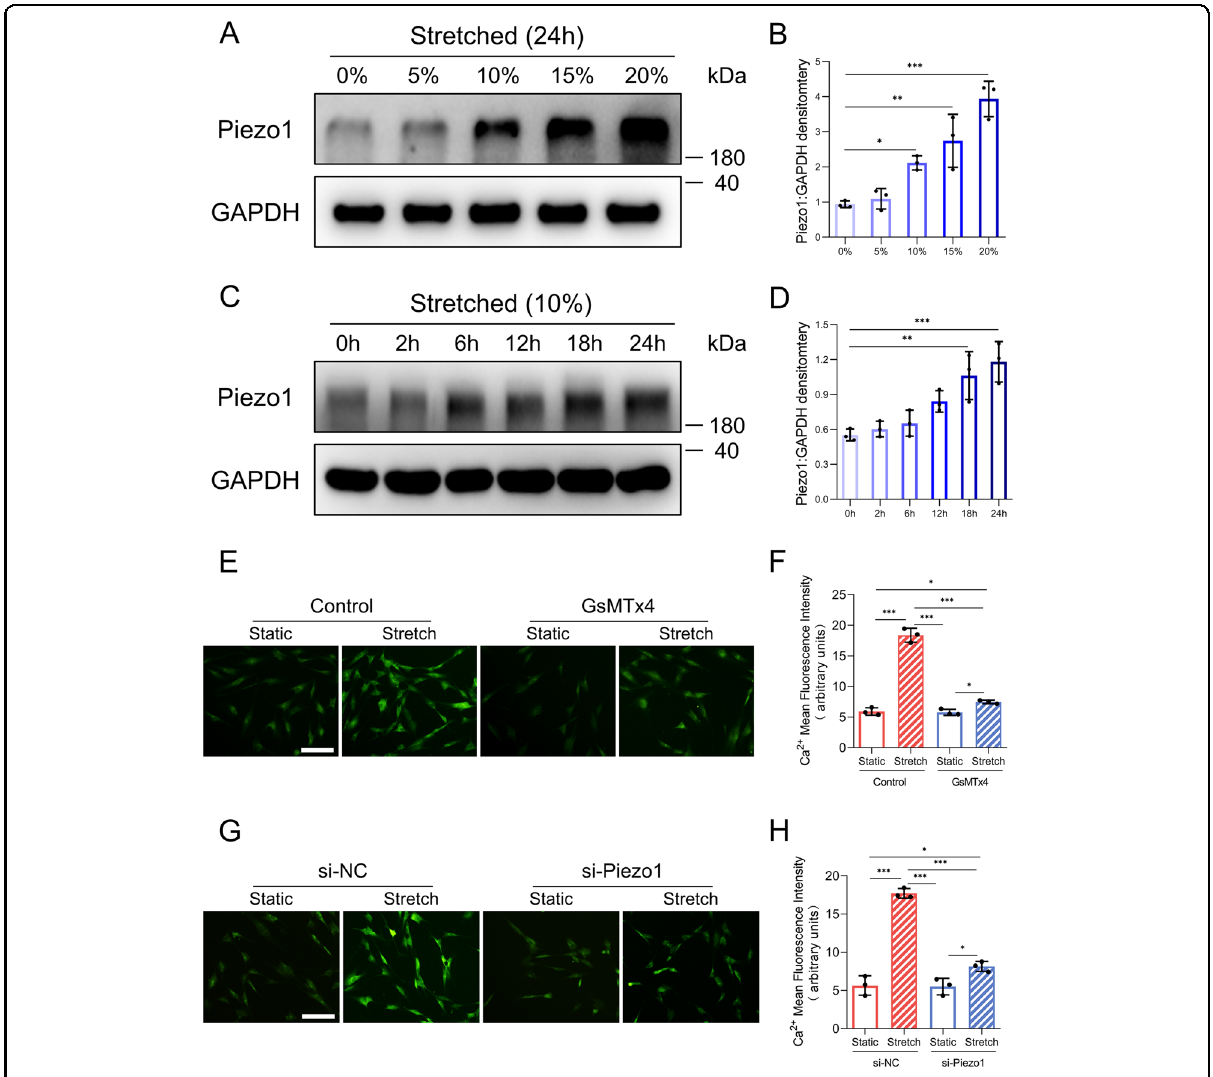
Fig. 2 Piezo1 expression and Piezo1-dependent calcium in fl ux in HDFs subjected to CMS. A Expression of Piezo1 in HDFs was determined by western blotting in a strength dependent manner. B Quantitative analysis of the expression level of Piezo1. C Expression of Piezo1 in HDFs was determined by western blotting in a time-dependent manner. D Quantitative analysis of the expression level of Piezo1. E Representative fl uorescence images of intracellular Ca 2 + in HDFs. (Scale bar: 100 μ m). F Mean fl uorescence intensity quanti fi cation of Ca 2 + levels in HDFs. G Representative fl uorescence images of intracellular Ca 2 + in HDFs in the context of Piezo1 knockdown. (Scale bar: 100 μ m). H Mean fl uorescence intensity quanti fi cation of Ca 2 + levels in HDFs in the context of Piezo1 knockdown. Ca 2 + concentration assay in HDFs was performed in the condition of mechanical stretch (10%, 1 h) and GsMTx4 exposure (1 h). The results are expressed as the means with SD ( n = 3). One-way ANOVA is used for all analysis. * P < 0.05, ** P < 0.01, *** P <